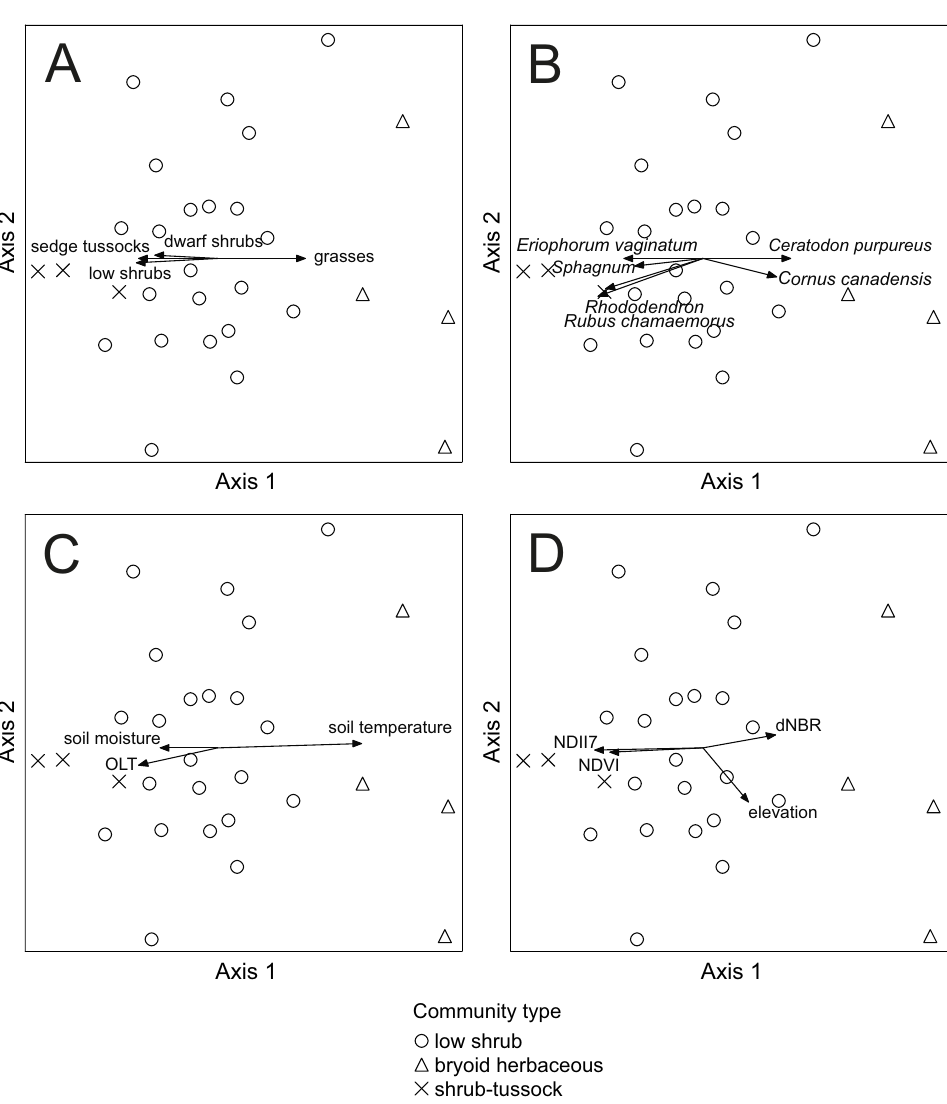
Figure 2. NMDS ordination of plant communities and relationships with ( A ) vegetation cover by growth form; ( B ) vegetation cover by species or genus; ( C ) soil properties; and ( D ) remote sensing variables. One outlier was excluded ( n = 29). Each point represents the plant community composition at a site. The vectors show the strength and direction of